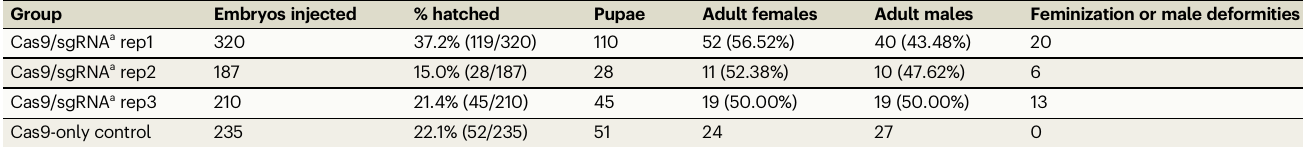
Table 1 | Ablation ef fi ciency and phenotypes of males following Cas9/sgRNA targeting of AsuMf in Armigeres subalbatus Group Embryos